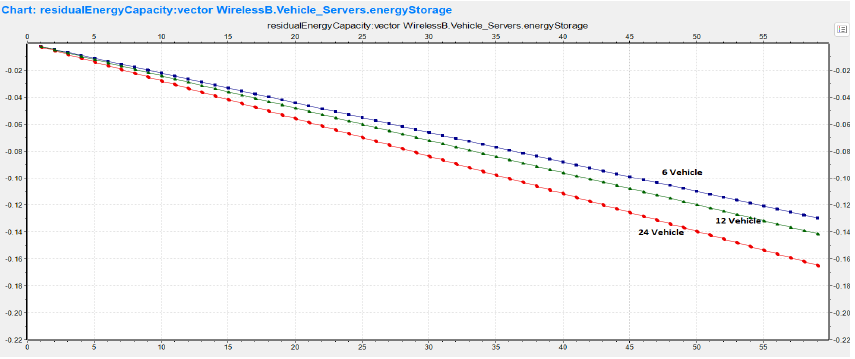
Figure 20. Residual energy stored for 6, 12, and 24 vehicles.